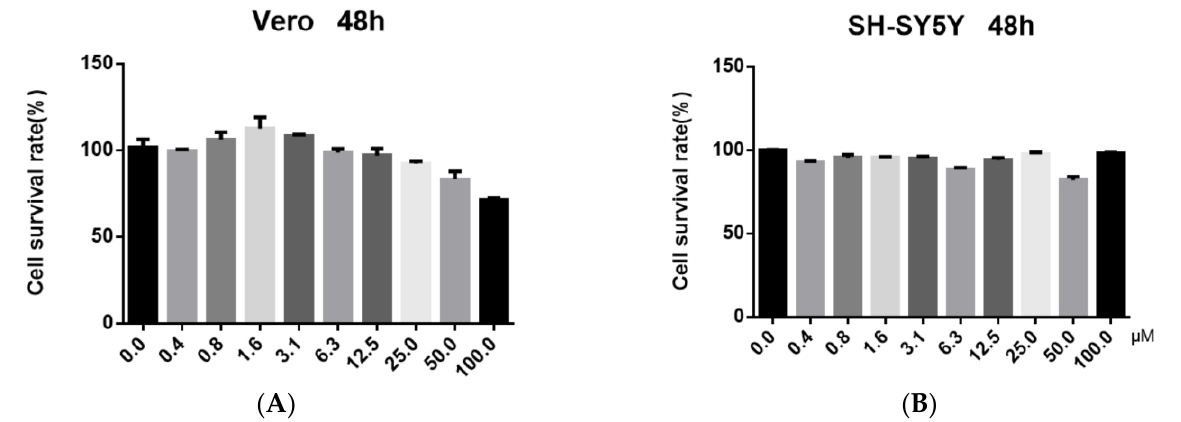
Figure 2. Cytotoxicity evaluation of officinaloside C on Vero (A) and SH-SY5Y (B) cell lines by using the CCK8 assay. Cell culture without iridoid compounds was used as a negative control. The data represent the percentage of cell viability in comparison with cell control, and the bars denote standard deviation (SD).